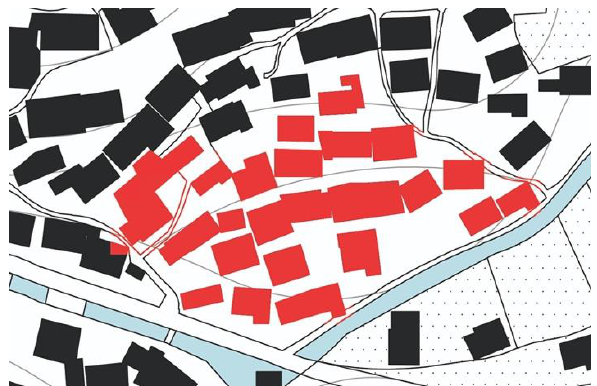
Figure 7. Parallel